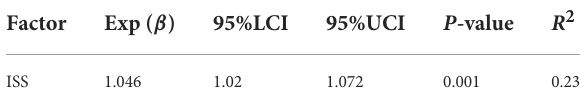
TABLE 2 Linear regression between serum SDC-1 and ISS in trauma patients at arrival at the